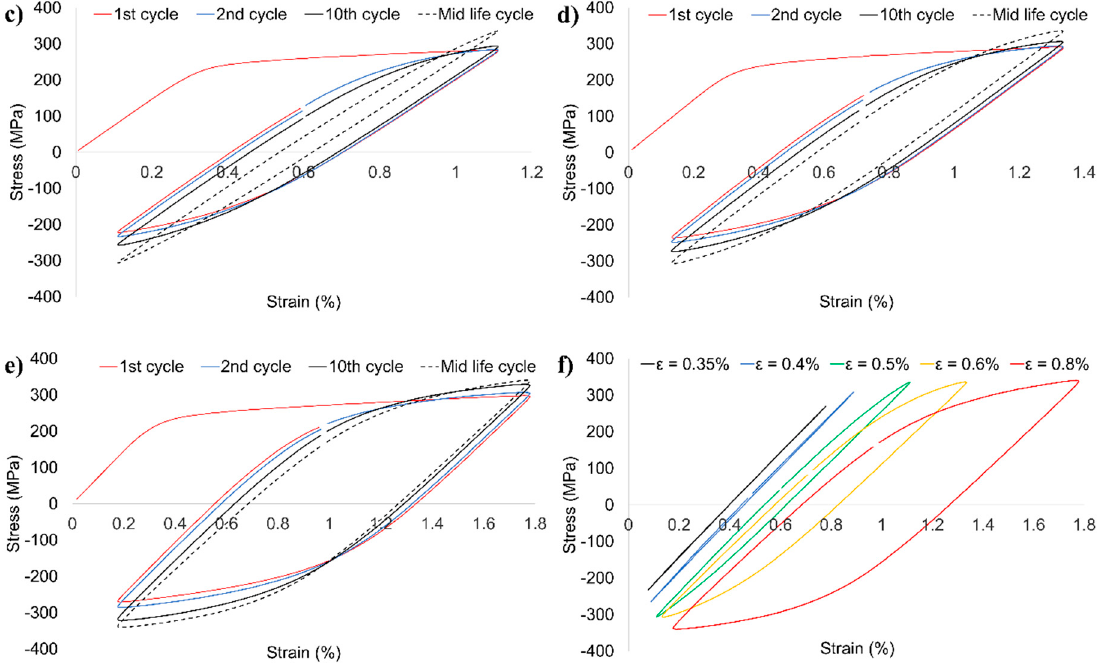
Figure 13. Stress–strain loops of FSW joint tested with ε = 0.35% ( a ), ε = 0.4% ( b ), ε = 0.5% ( c ), ε = 0.6% ( d ), ε = 0.8% ( e ), and the comparison of mid-life loops ( f ).